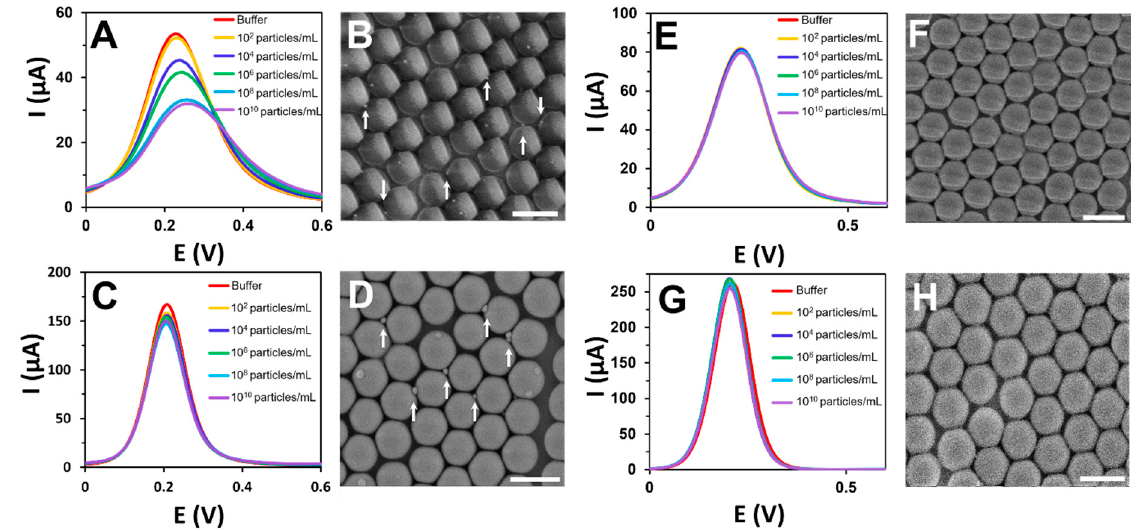
Figure 3. Differential pulse voltammograms obtained using a gold surface modified with a mono- layer of streptavidin-modified PS spheres with and without silica deposited on the top surface of the spheres. Working electrode upon consecutive incubations with increasing concentrations of biotinylated gold nanoparticle solutions ( A ) with and ( C ) without silica deposition, and control using an IgG-modified sensor ( E ) with and ( G ) without silica. ( B , D , F , H ) show corresponding SEM images of the electrode after sensing corresponding to ( A , C , E , G ), respectively. All scale bars are 500 nm.